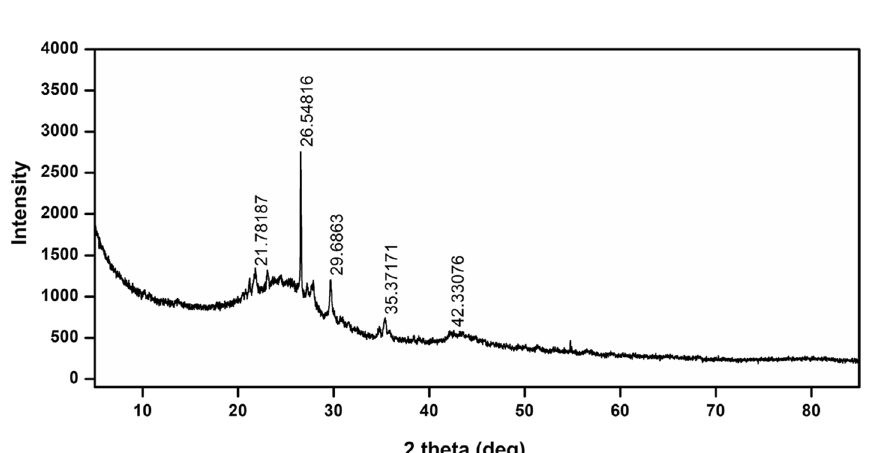
Fig. 3 X-ray diffraction plot of Synthesized Activated